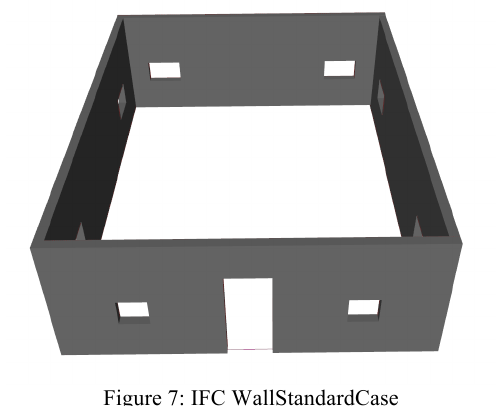
Figure 7: IFC WallStandardCase